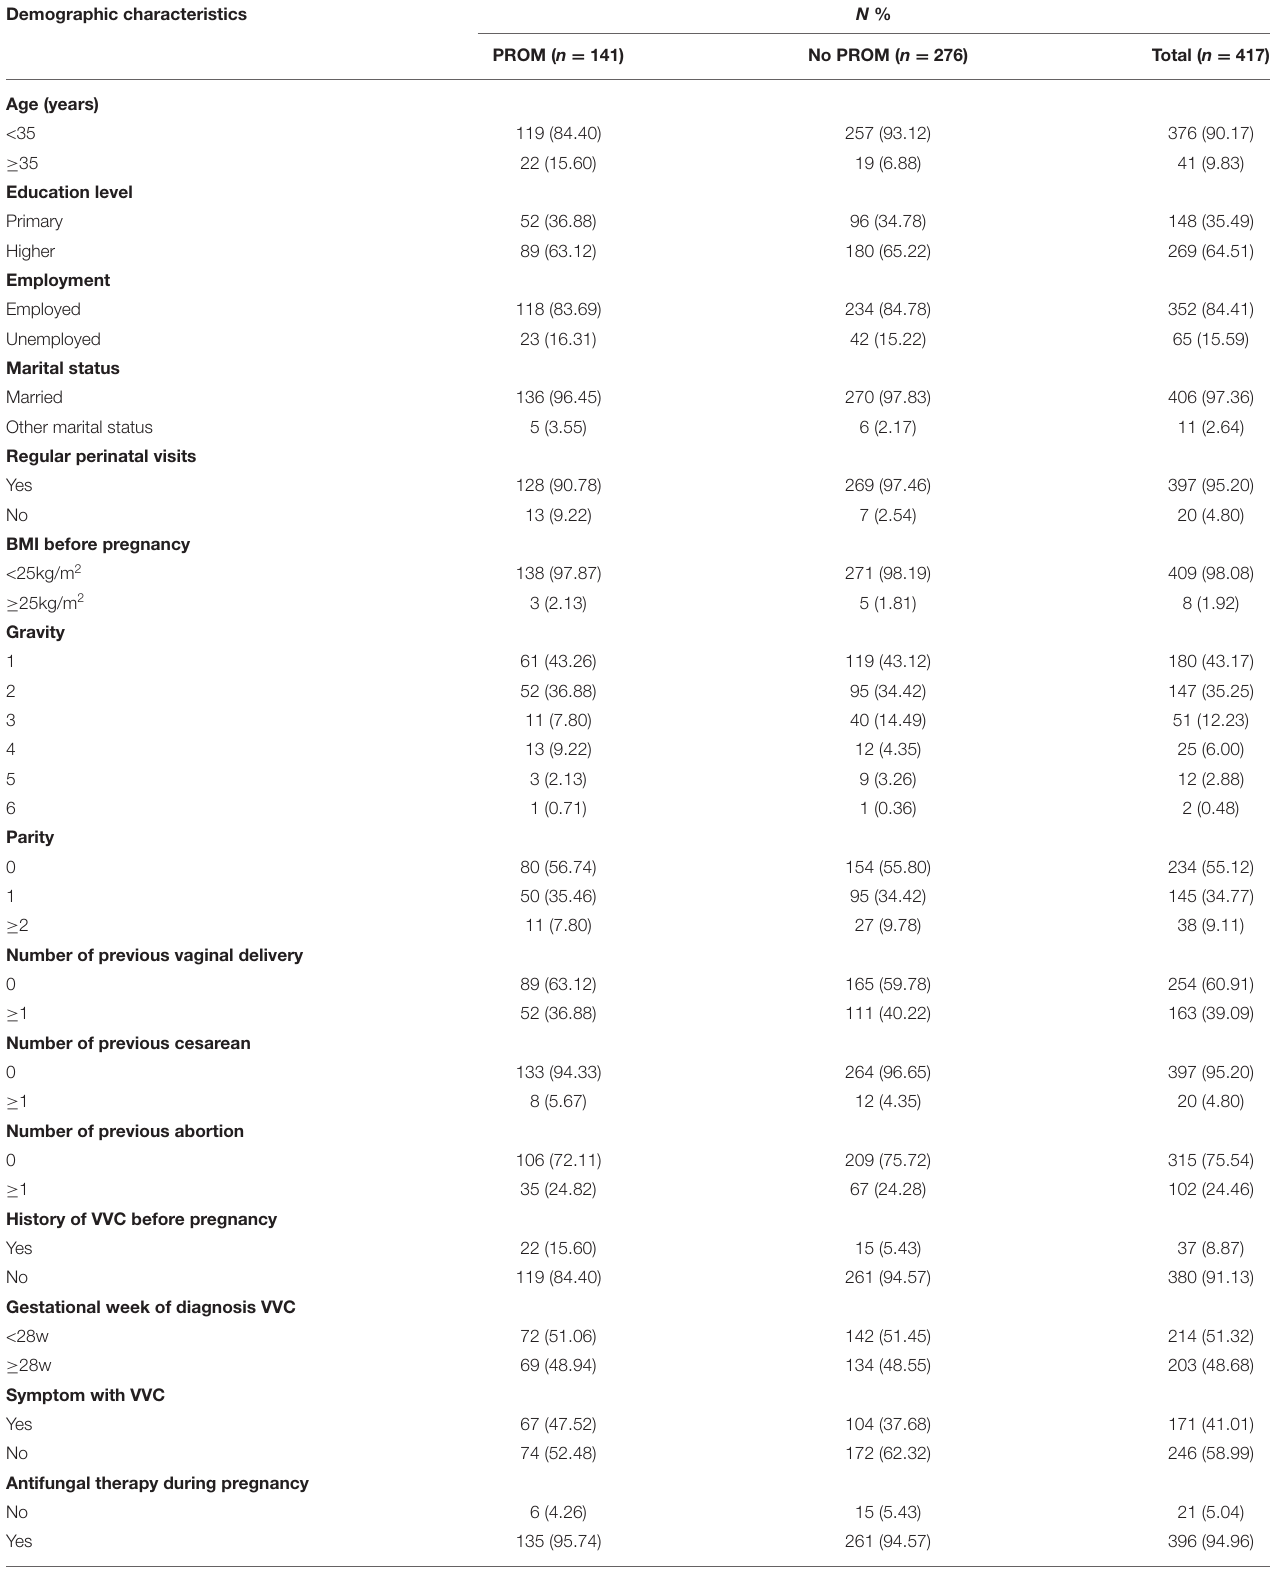
TABLE 1 | Difference between demographic and clinical characteristics of PROM and no PROM groups. Demographic